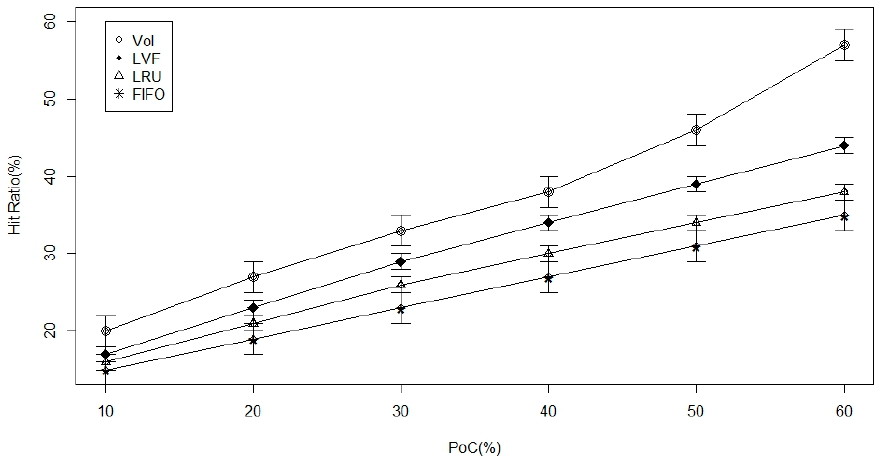
Figure 7. Hit-ratio versus the percentage of nodes with caches in a randomly generated ICN-based WBAN.